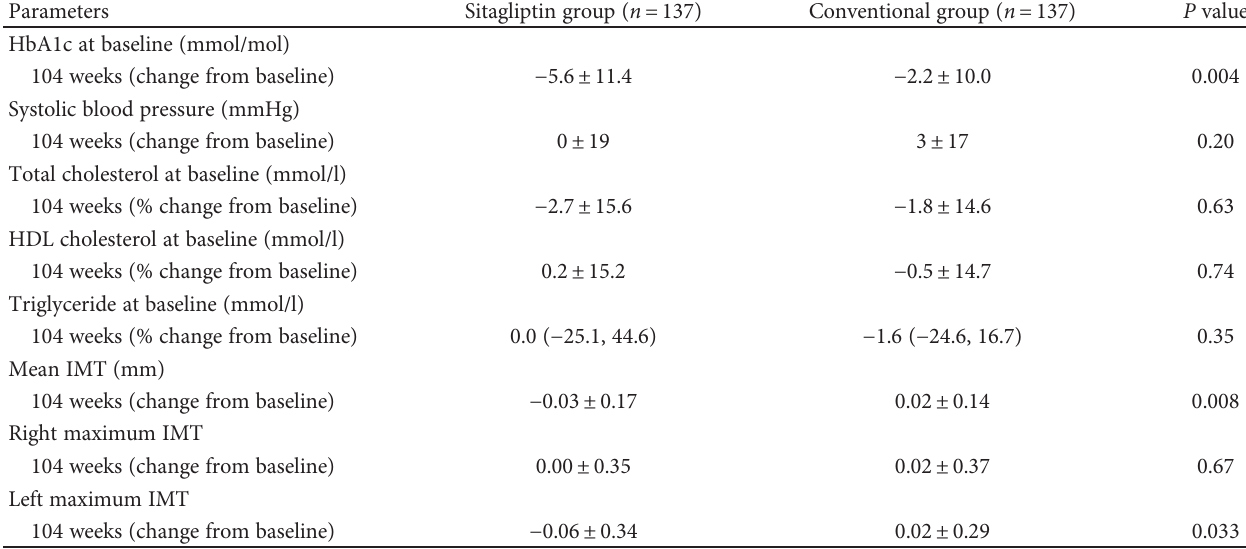
Table 2: E ff ects of sitagliptin on glucose metabolism, blood pressure lipid metabolism, and IMT.